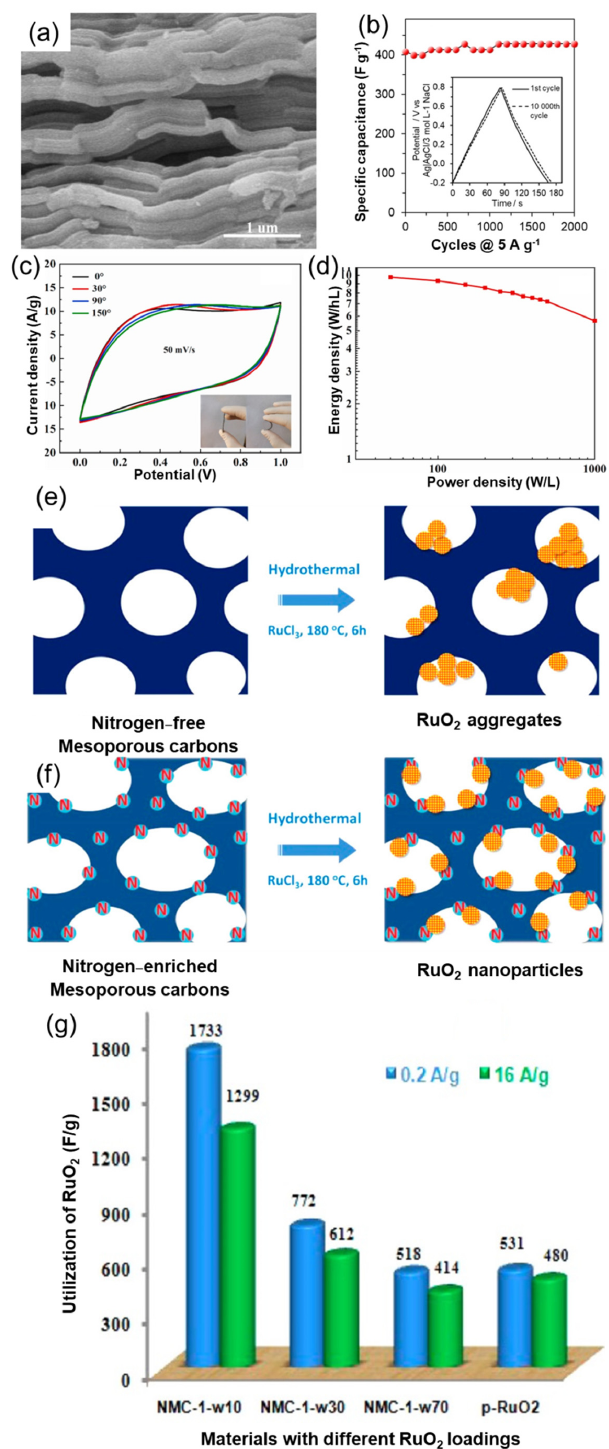
Figure 8. ( a ) Scanning electron microscopic image of N-doped mesoporous carbon obtained from the silica template method followed by the carbonization [127]. ( b ) Cyclic stability of activated carbon derived from the chitin biopolymer via polystyrene latex templating method followed by the KOH activation process (inset shows the GCD profile after the cyclic stability experiment) [128]. ( c ) CV and ( d ) Ragone plot of flexible supercapacitor fabricated from the biomass-derived carbon/graphene composite material [129]. ( e , f ) Schematic representation of aggregated as well as evenly distributed RuO 2 nanoparticles over the undoped and N-doped porous carbon structure [131]. ( g ) 2D plot showing the specific capacitance variations with the different RuO 2